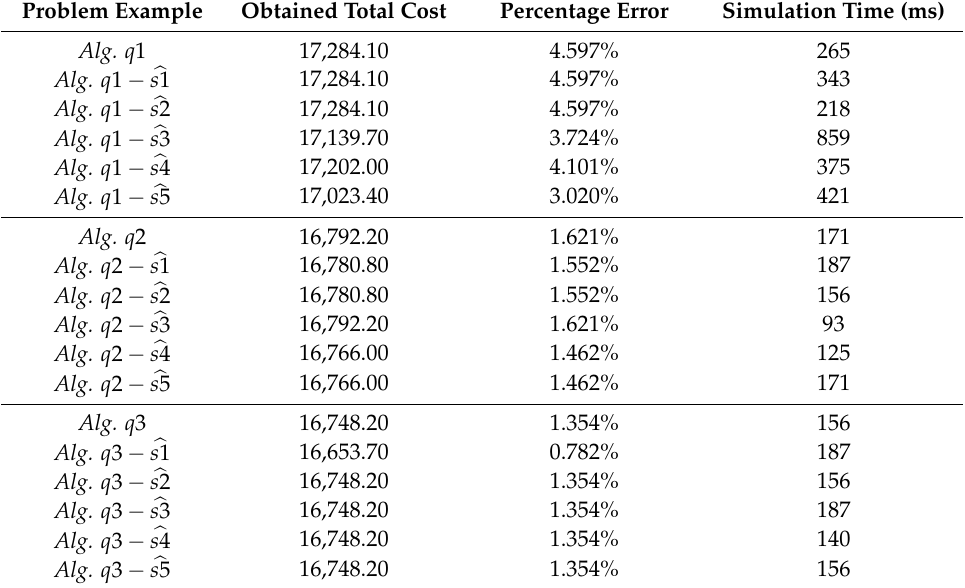
Table 6. Obtained results for regular network GR-2 (Optimal cost 16,524.40).